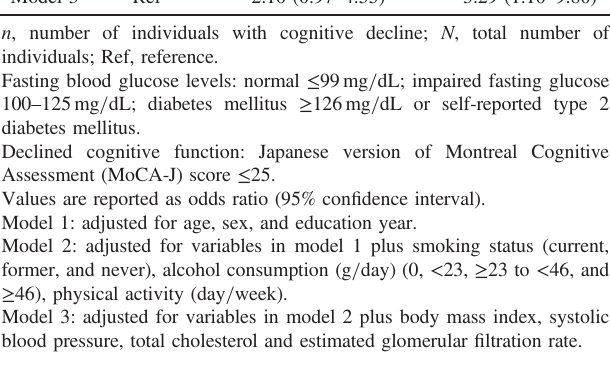
Table 4. MoCA-J scores in 2018 according to fasting blood glucose levels at baseline strati fi ed by age group, Aichi, 2002 – 2018 P for linear Impaired Fasting Diabetes P -value a Normal trend b Glucose Mellitus